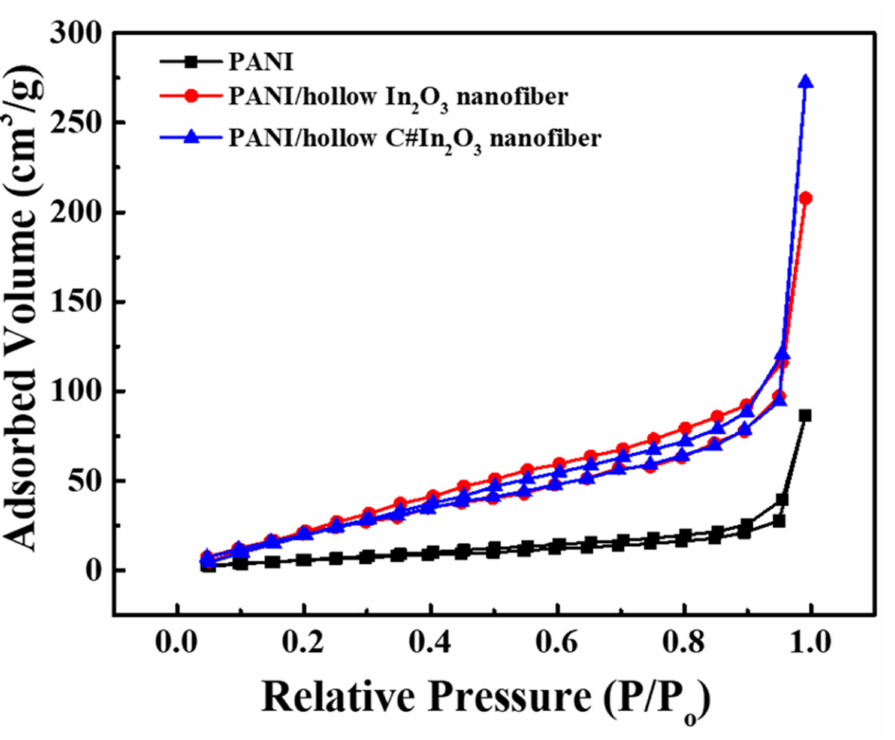
Figure 6. The BET profiles of PANI, PANI/hollow In 2 O 3 nanofiber, and PANI/hollow C#In 2 O 3